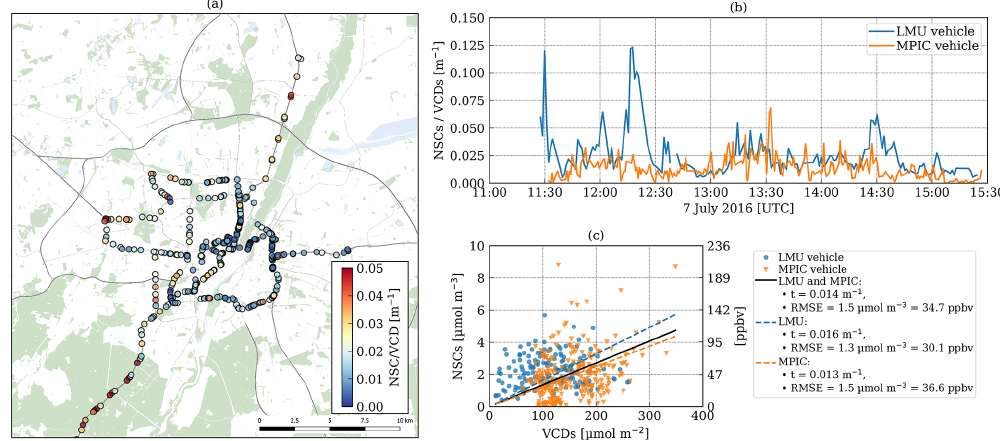
Figure 10. (a) Map of ratios of NO 2 NSCs (µmolm − 3 ) to VCDs (µmolm − 2 ) measured by in situ monitors and MAX-DOAS on board the LMU and MPIC vehicles. (b) The time series of ratios measured with the two vehicles and (c) a scatter plot of NSCs and VCDs. Map data from © OpenStreetMap contributors 2021. Distributed under the Open Data Commons Open Database License (ODbL)